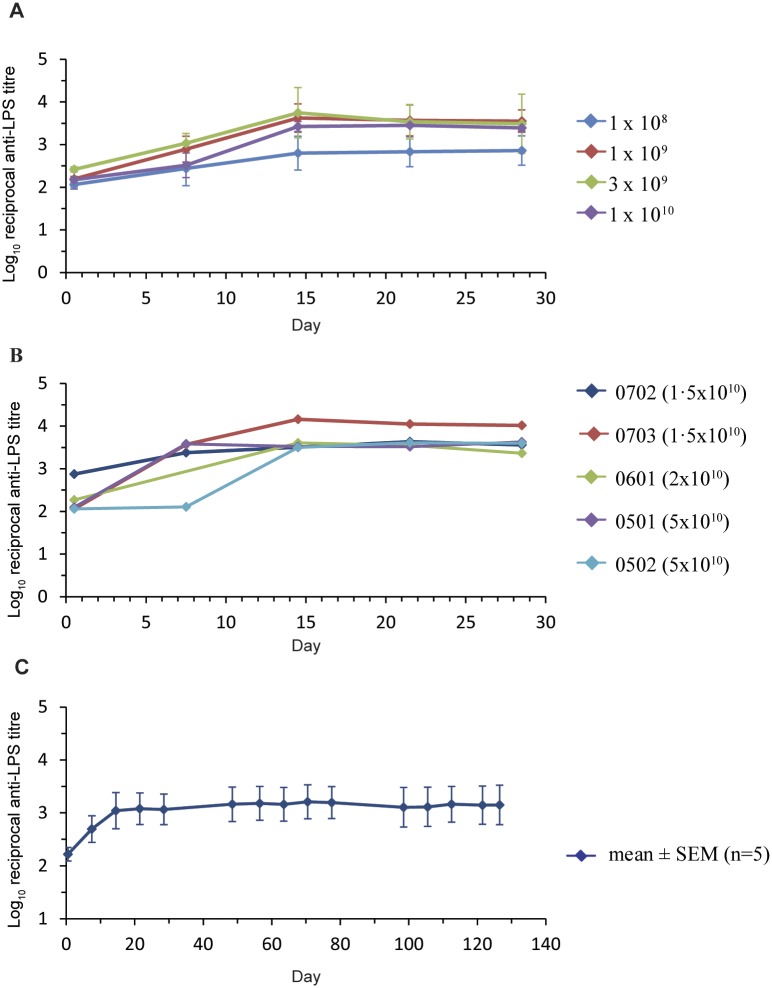
Anti-LPS antibody titers following administration of EGFRminicellsPac.Blood samples were collected at dosing and serum was analyzed for anti-LPS IgG. Results are expressed as the reciprocal antibody titer, expressed as Log10. The x-axis shows days of treatment and error bars indicate the standard error of the mean. (A) The mean anti-LPS antibody titer for each dose level (1x108, n = 5; 1x109, n = 5; 3x109, n = 4; 1x1010, n = 5) up to and including the MTD for Cycle 1 of treatment (5 doses). (B) Anti-LPS antibody responses in 5 individuals treated with EGFRminicellsPac at dose levels above the MTD. (C) Anti-LPS antibody responses in 5 individuals that received at least 15 doses of EGFRminicellsPac.